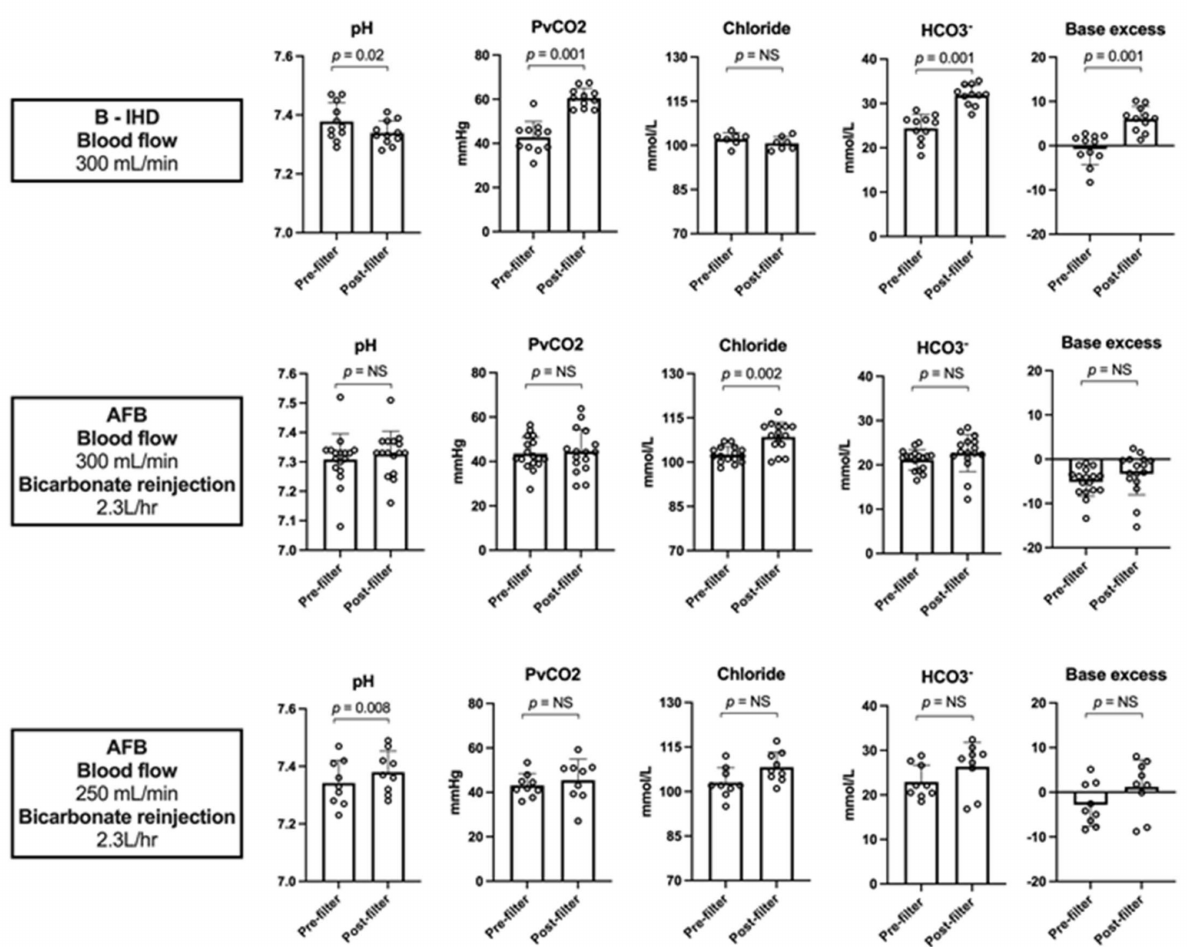
Figure 2. Venous gases in the blood returning to the patients during bicarbonate intermittent hemodialysis (B—IHD) and acetate-free biofiltration (AFB). PvCO 2 , venous carbon dioxide pressure; HCO 3 ,